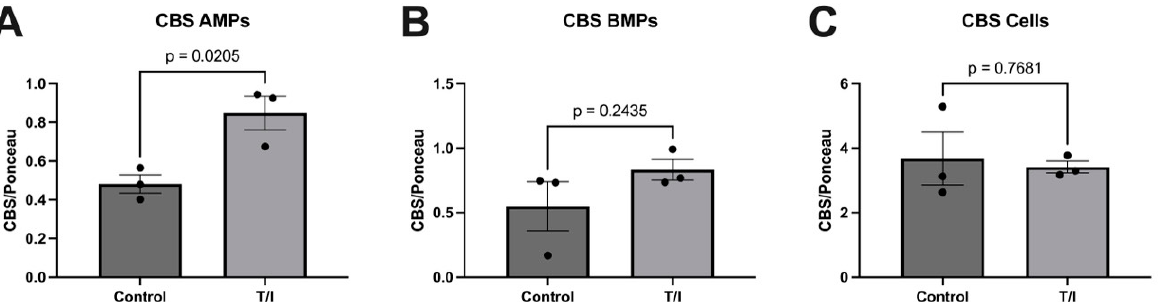
Figure 2 . Analysis of CBS in apical microparticles (AMPs), basolateral microparticles (BMPs), and hCMEC/D3 human brain microvascular endothelial cells. Data are normalized to Ponceau staining.